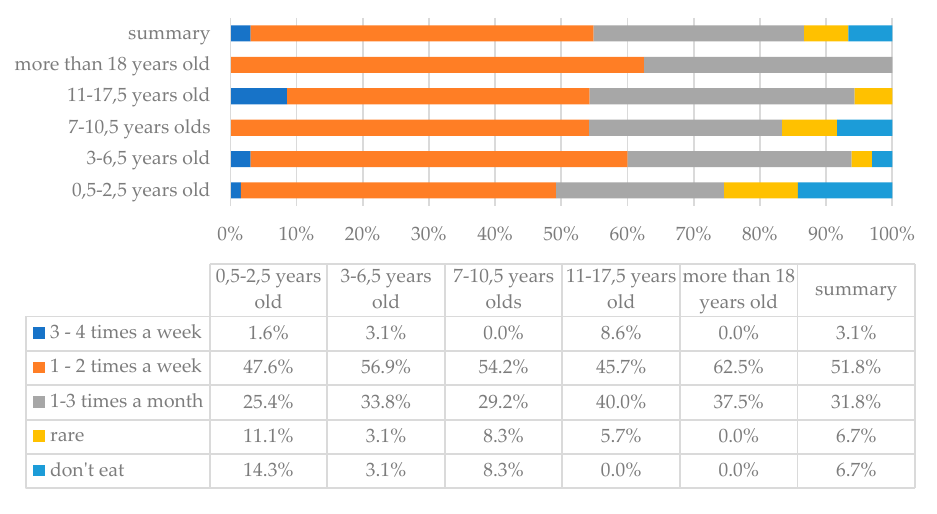
Figure 6. Frequency of fish consumption in the study group of individuals with DS by age. The analysis showed that 24 (12.3%) people do not give their children nuts for health reasons (allergy), and 141 (72.3%) do not give nuts without justification. The remaining persons regularly eat nuts (Figure 7).